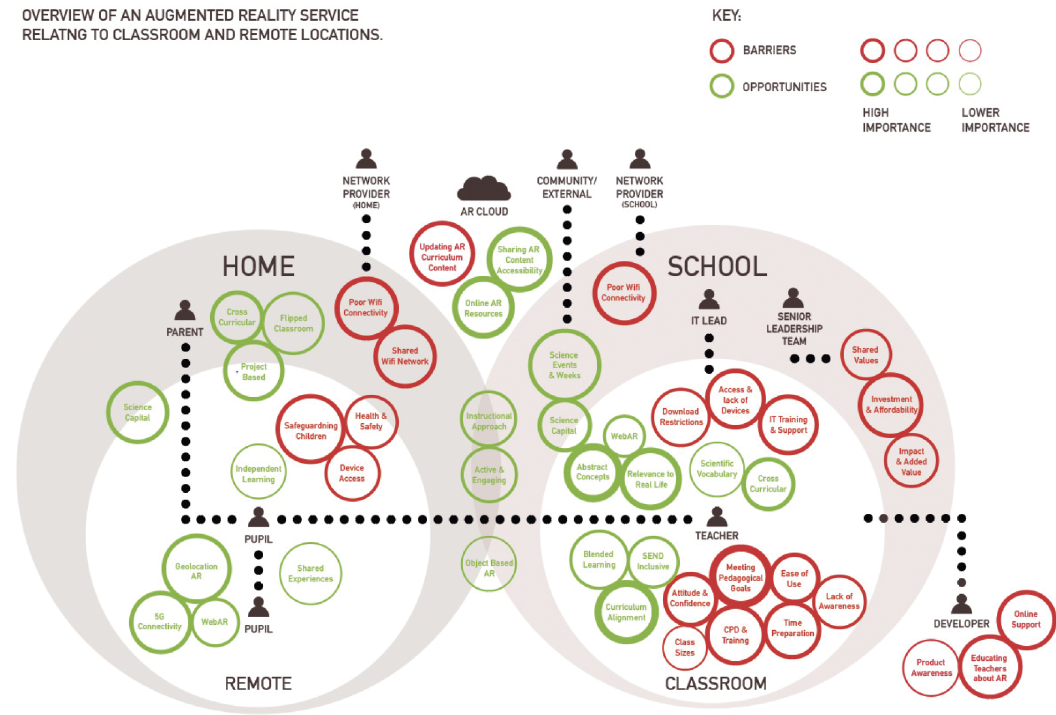
Figure 6. Diagram to show a service using Augmented reality from classroom and remote locations